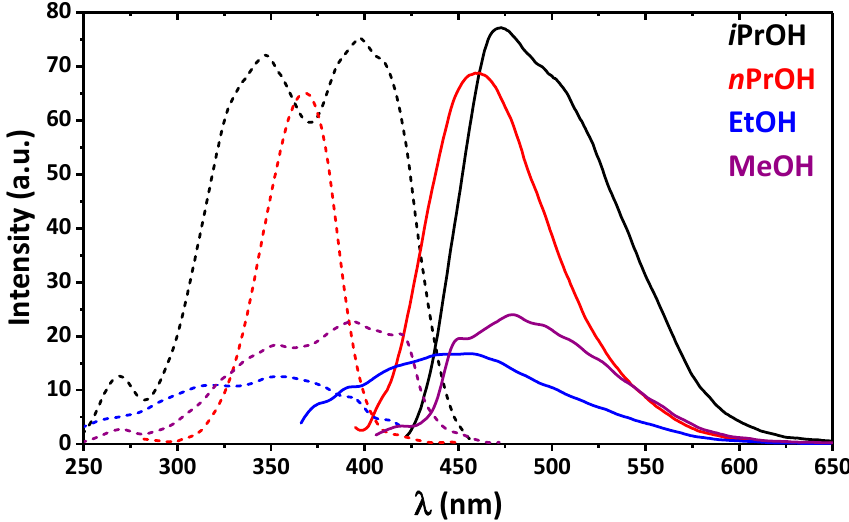
Figure 3. Emission (solid line) and excitation (dashed line) spectra of 4 in MeOH ( λ exc = 395 nm, λ em = 480 nm), EtOH ( λ exc = 350 nm, λ em = 440 nm), n PrOH ( λ exc = 360 nm, λ em = 460 nm) and i PrOH ( λ exc = 400 nm, λ em = 475 nm).